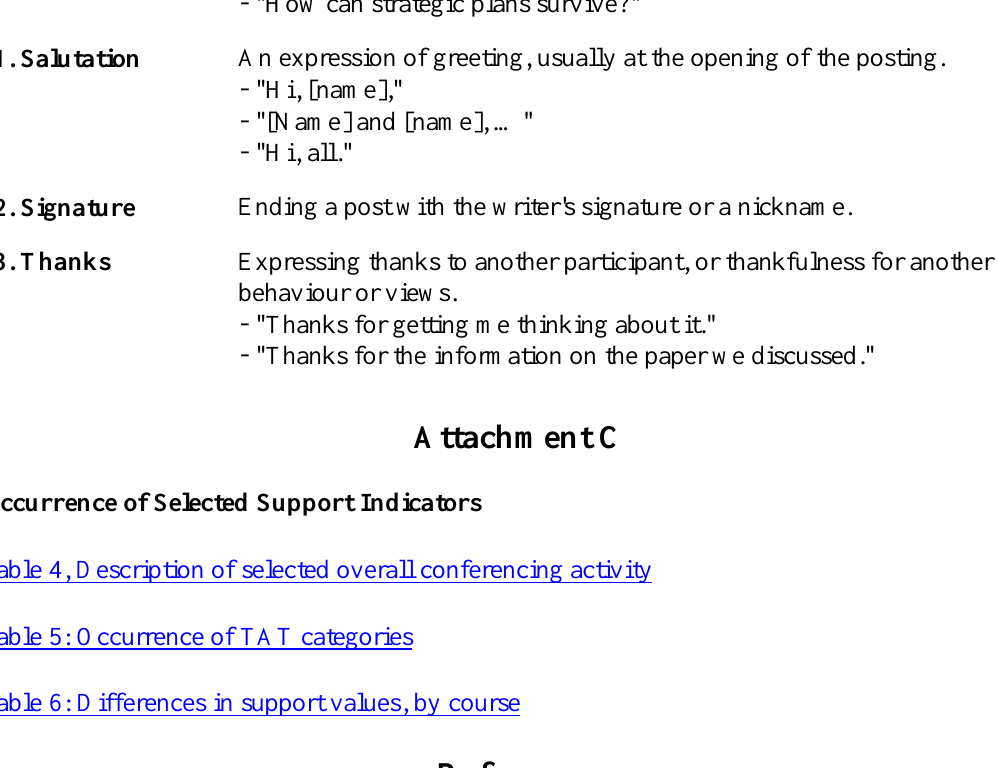
Table 4, Description of selected overall conferencing activity Table 5: Occurrence of TAT categories Table 6: Differences in support values, by